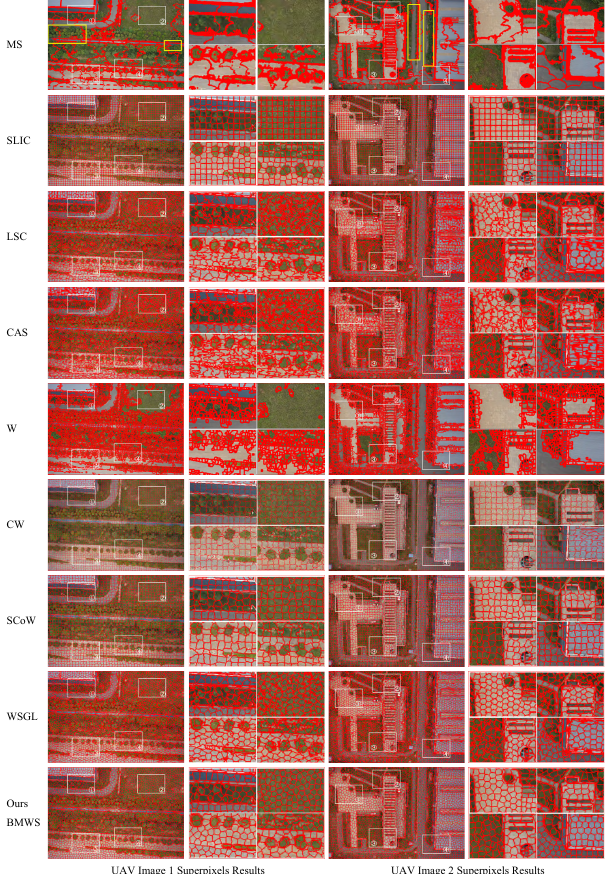
Figure 4. Extensive comparison experiments of